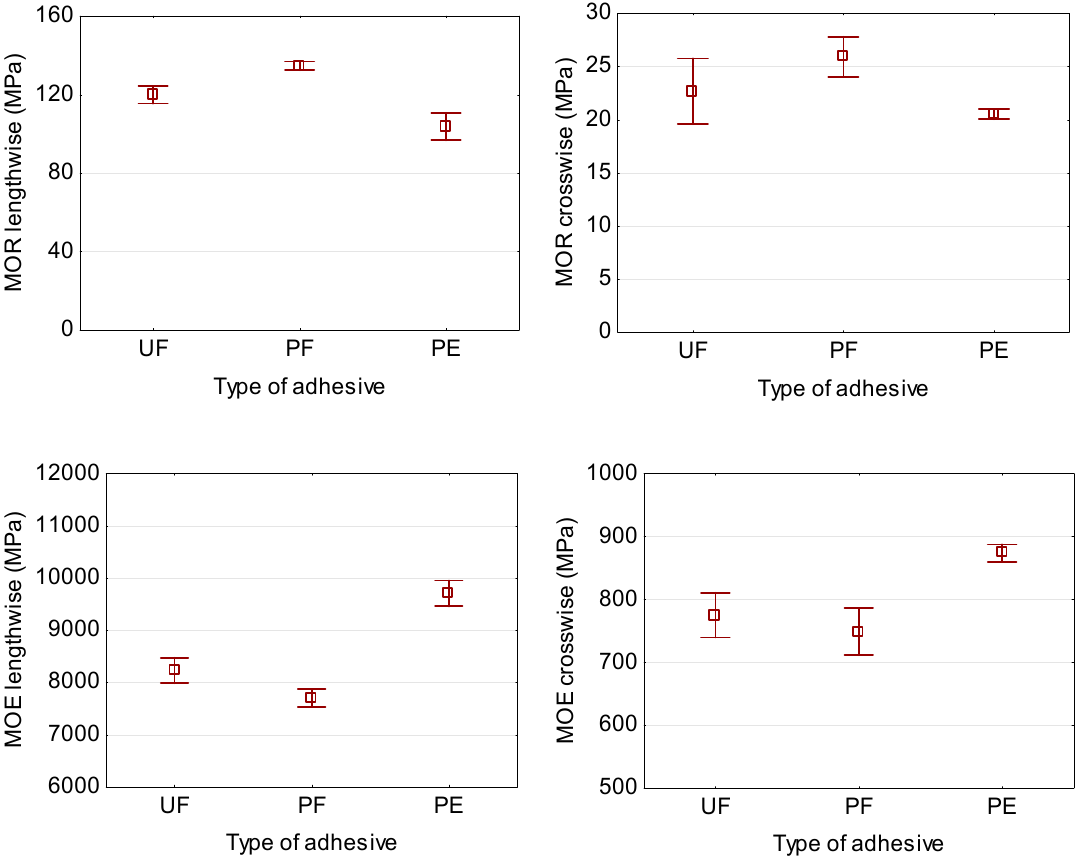
Figure 8. Bending strength and modulus of elasticity in the bending of plywood panels bonded with different types of adhesive (lengthwise = in parallel and crosswise = in perpendicular directions). Mean values obtained for bending strength and MOE of plywood panels were higher than the limit values for structural purpose solid wood panels (32 MPa for MOR ( (cid:107) ) and 5 MPa for MOR ( ⊥